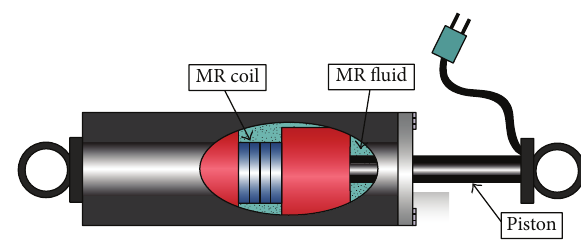
Figure 5: Schematic of RD-8040-1 MR damper.